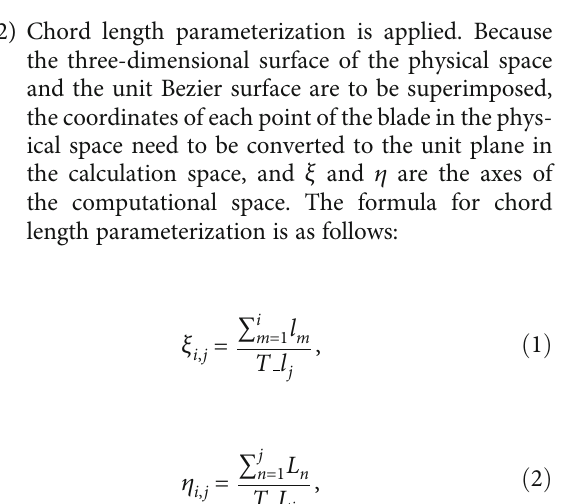
Figure 1: The construction process of parametric